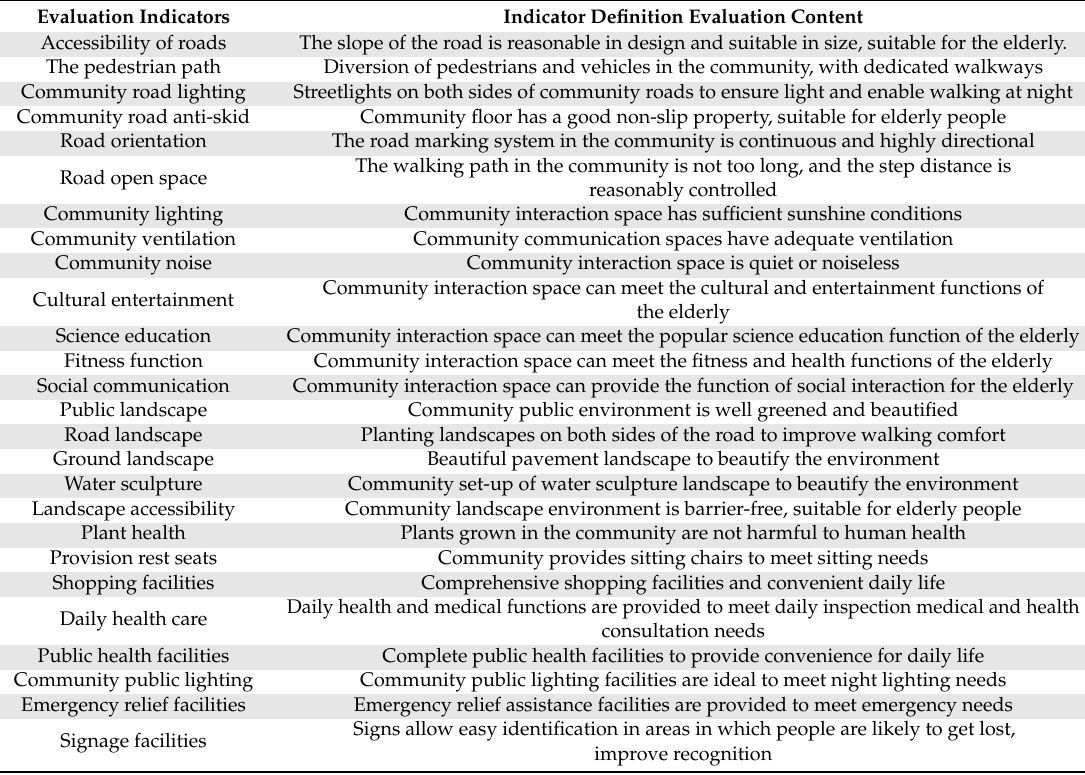
Table 4. Evaluation index preliminary selection statistics and interpretation